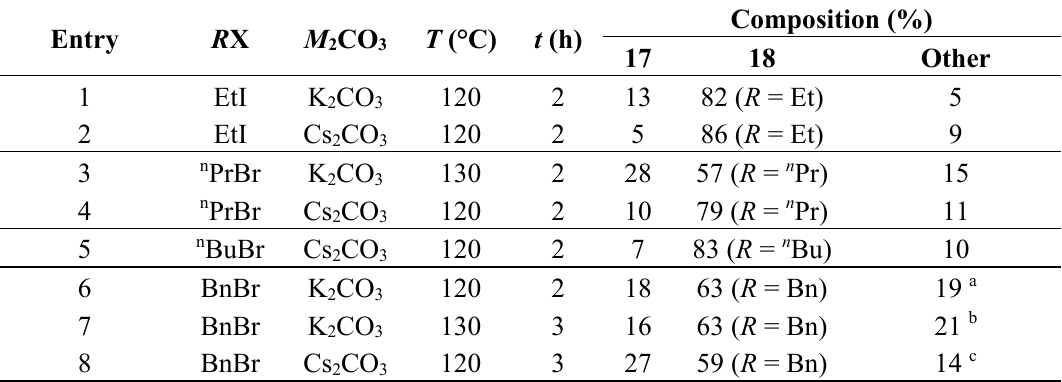
Table 4. Alkylation of diethyl ethoxycarbonylmethylphosphonate ( 17 ) under MW